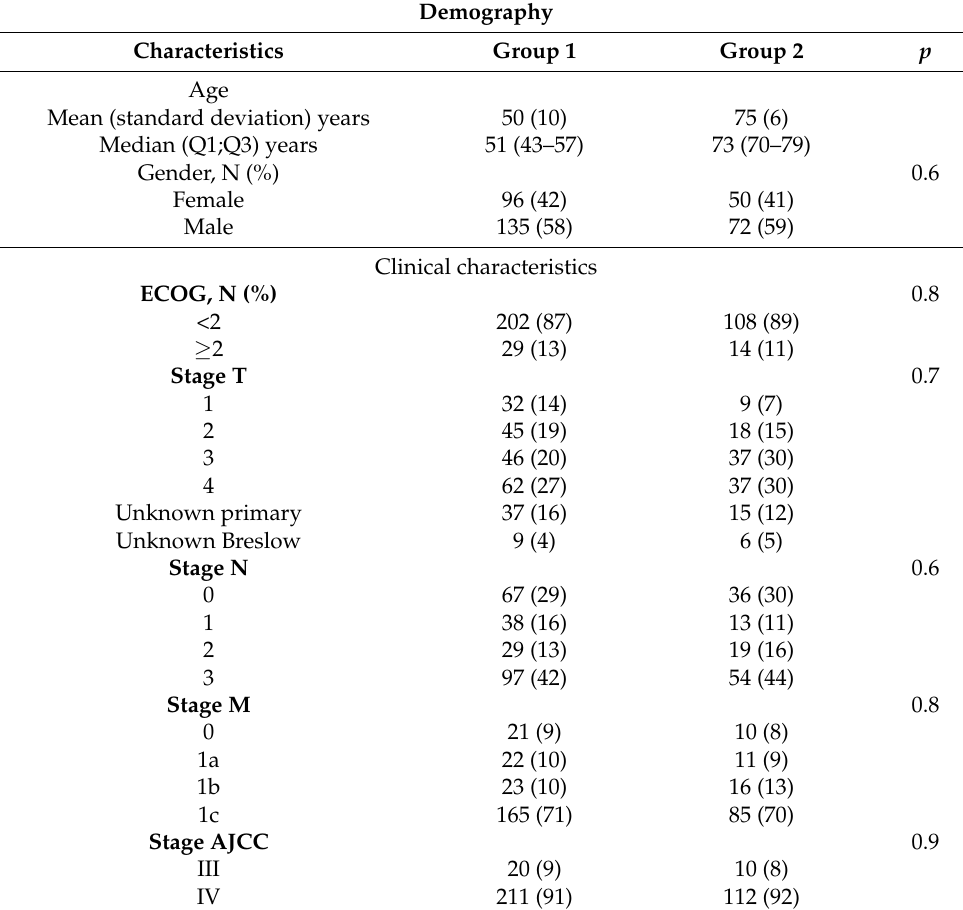
Table 1. Demography, clinical, and treatment characteristics of the cohort.